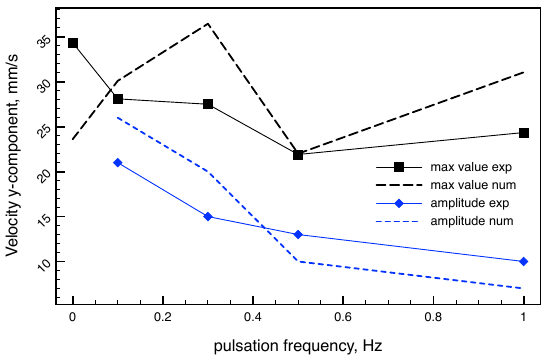
Figure 12. Dependencies of liquid metal flow parameters on TMF pulsation